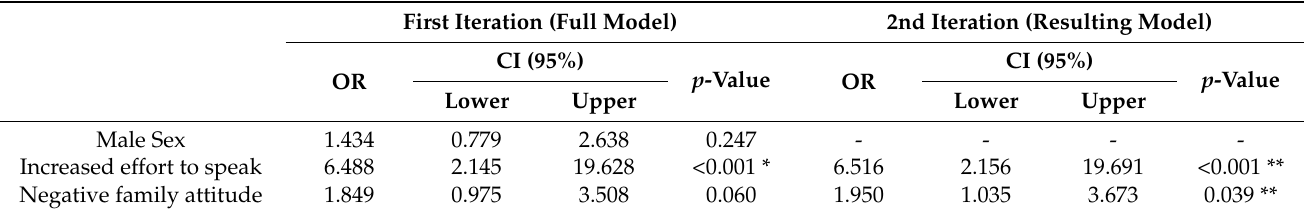
Table 3. Multivariate logistic regression model for prediction of stuttering in